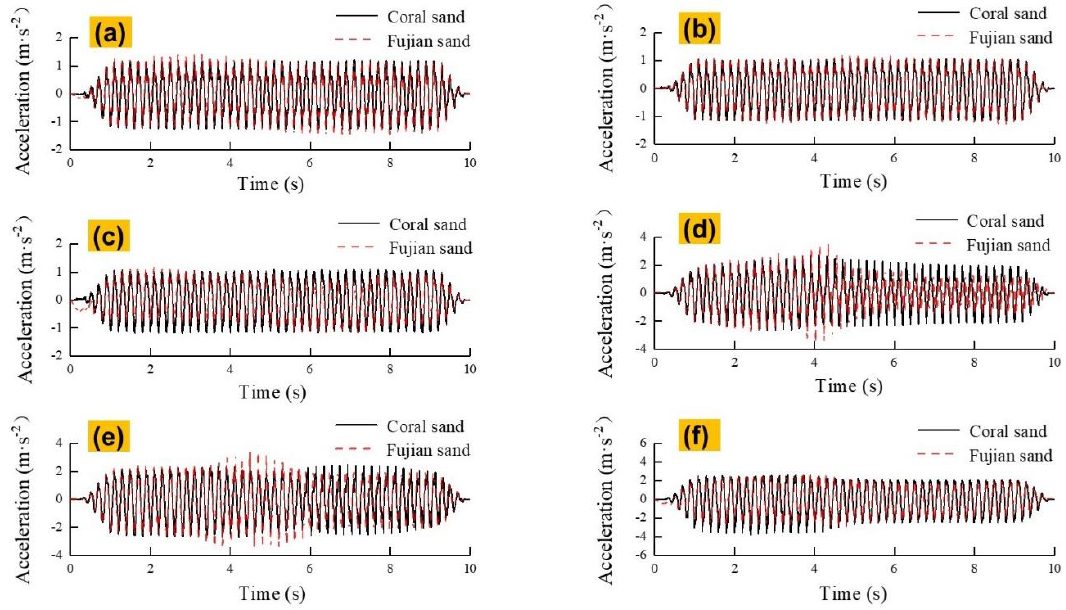
Figure 9. Acceleration time history curves: ( a ) A1 position under 0.1 g intensity; ( b ) A2 position under 0.1 g intensity; ( c ) A3 position under 0.1 g intensity; ( d ) A1 position under 0.2 g intensity; ( e ) A2 position under 0.2 g intensity; and, ( f ) A3 position under 0.2 g intensity.